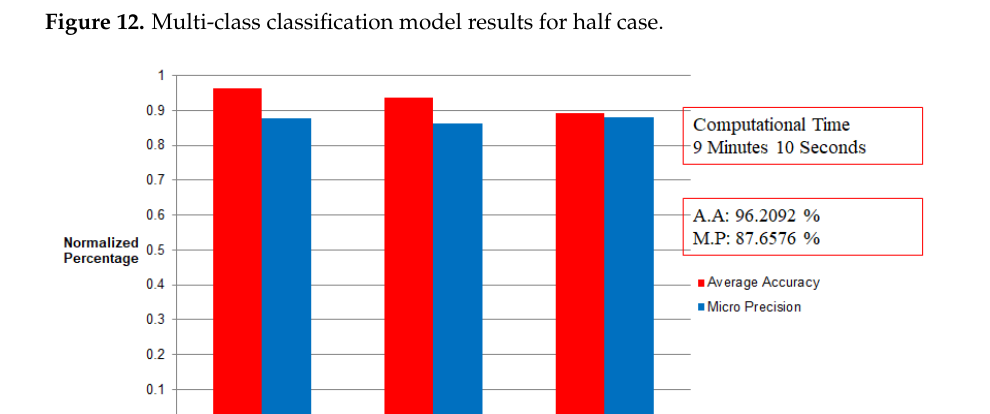
Figure 12. Multi-class classification model results for half case.